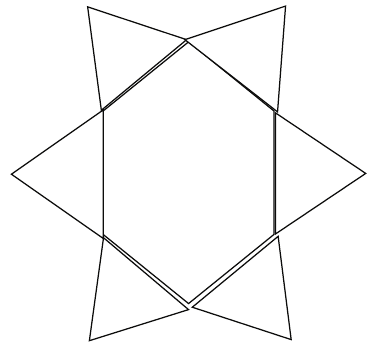
Figure 6: Total fuzzy graph of fuzzy graph G .